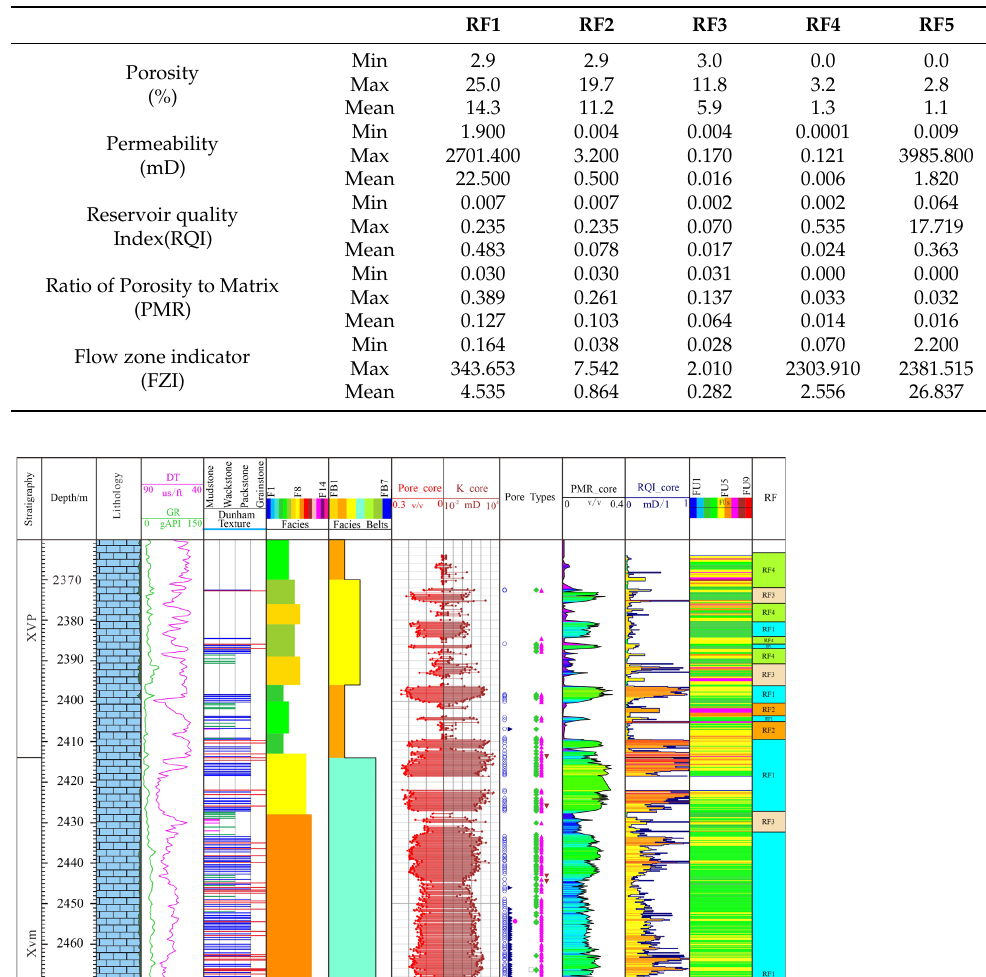
Table 3. Statistical parameters calculated for reservoir facies (RFS) of the Callovian − Oxfordian stage.